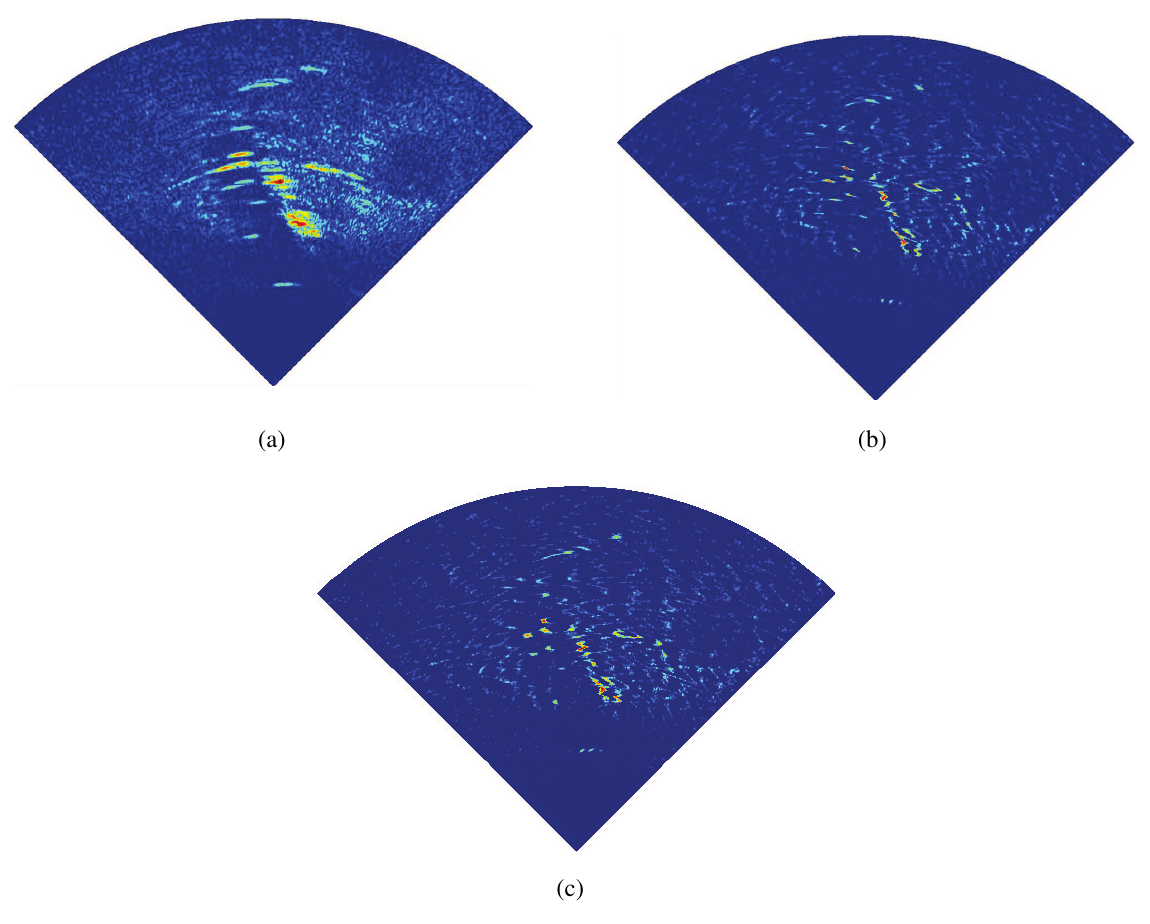
Figure 7. Superresolution results of the measured data processed by the RL algorithm and the proposed MAP algorithm. ( a ) Measured real aperture image. ( b ) RL algorithm. ( c ) Proposed MAP